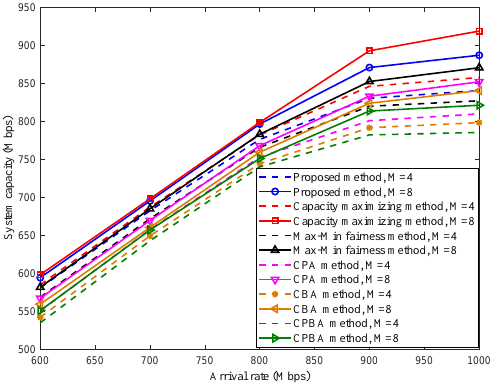
Figure 8. System capacity of different methods in scenario